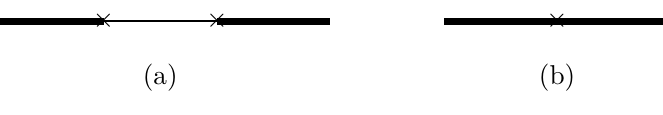
Figure 3 . This figure shows two Feynman diagrams contributing to the disk amplitude with two external closed